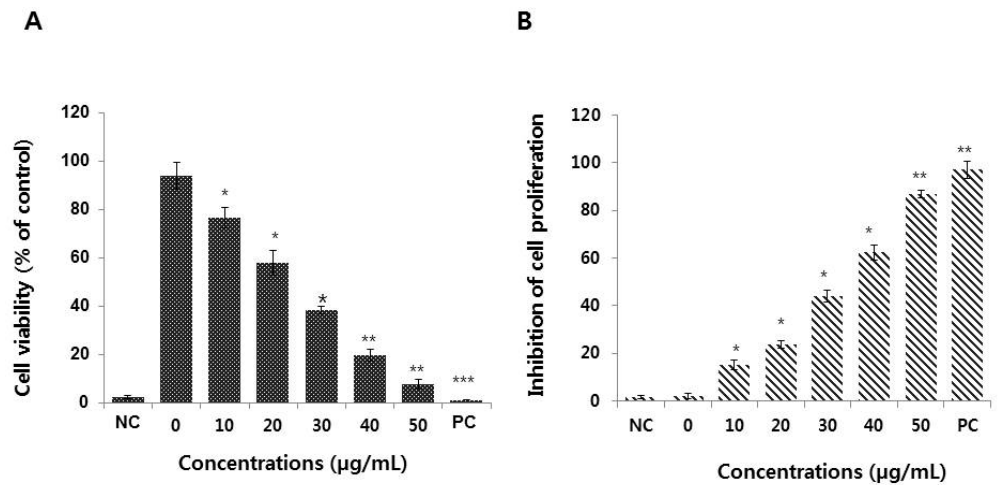
Figure 2. E ff ects of graphene oxide on the viability and proliferation of HEK293 cells. ( A ) The viability of HEK293 cells was determined by a CCK-8 assay after 24 h of exposure to di ff erent concentrations of graphene oxide. ( B ) Cell proliferation was assessed using a BrdU cell proliferation assay. The results are expressed as the means ± standard deviation of three independent experiments. A significant di ff erence was observed between treated and untreated cells. * p < 0.05 was considered significant; ** p < 0.01 was considered highly significant and *** p < 0.001 was considered very highly significant. HEK293 cells show reduced ( p < 0.05) viability and proliferation with increasing concentrations of graphene oxide. We have previously shown the dose-dependent toxic e ff ects of graphene oxide in a variety of cells, including human breast cancer, ovarian cancer, neuroblastoma, and human lung